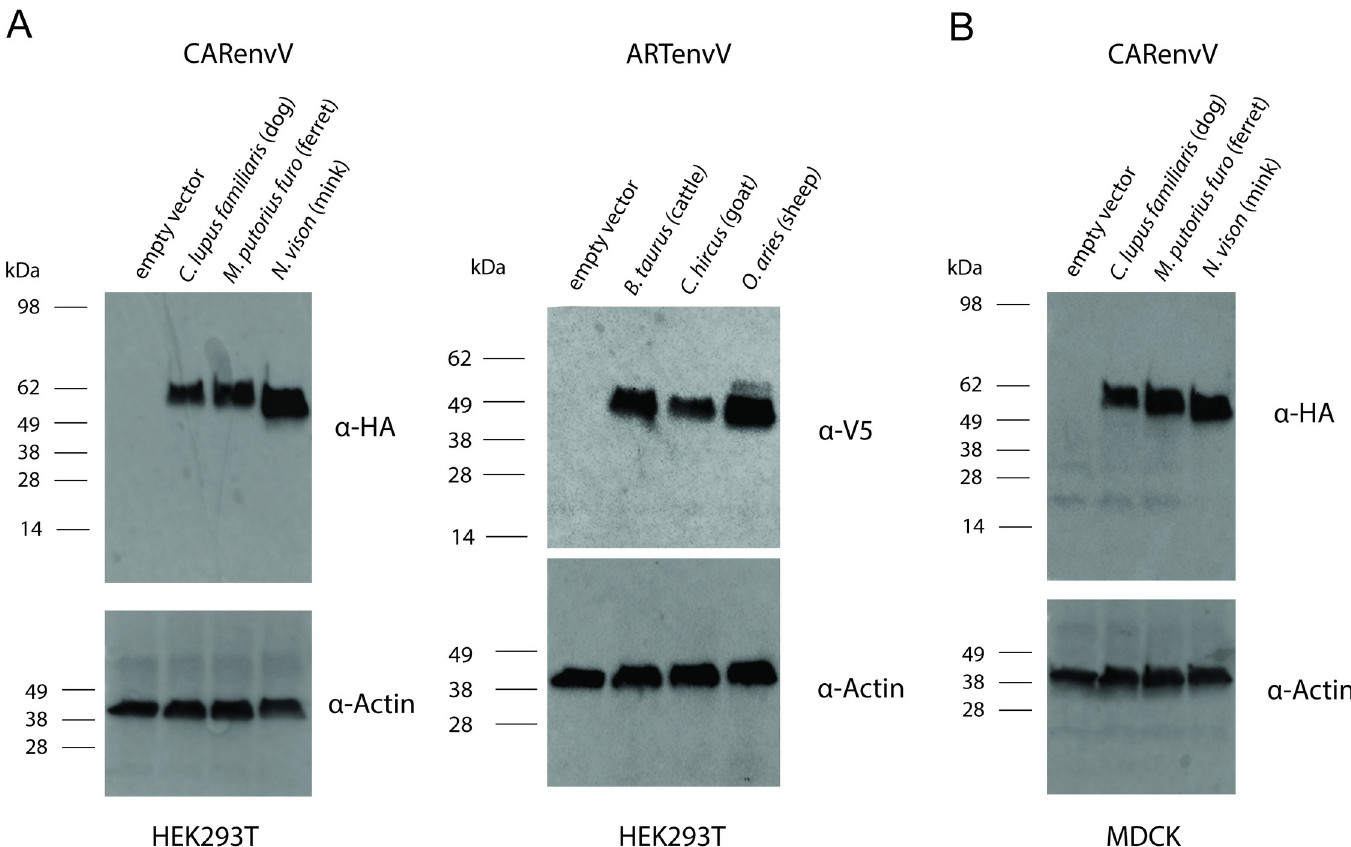
Fig 11. Ectopic expression of CARenvV and ARTenvV. A. Immunoblotting analysis of 293T cells transfected with the plasmids expressing empty vector or the indicated CARenvV and ARTenvV constructs. B. Immunoblotting analysis of MDCK cells transduced with the plasmids expressing empty vector or the indicated CARenvV constructs. The blots shown are representative of at least two independent experiments.